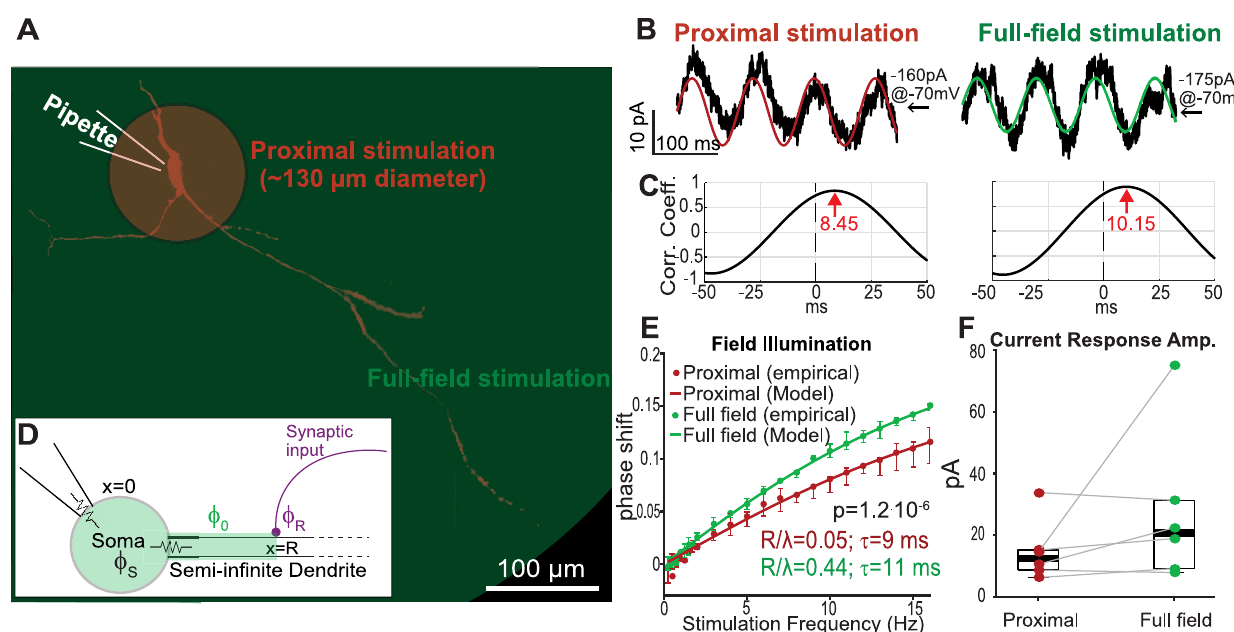
Fig 2. Somatic current responses to periodic illumination of SNr GABAergic neurons shift depending on the extent of the dendritic arbor activated. A: Collapsed two-photon image of typical SNr GABAergic neuron, filled with Alexa Flour. To compare distal and proximal inputs, optogenetic stimulation was applied under two conditions: 1) illuminating a diameter of ~130 μ m around the soma, targeting the soma and proximal dendrites (proximal, red); and 2) full-field illumination stimulating the entire dendritic arbor (full-field, green). B: Optogenetic sinusoidal waveforms at various frequencies (0.25–16 Hz) were delivered under the proximal (red) and full-field (green) stimulation conditions. Somatic whole-cell current response (black) is a phase shifted sinusoid. C: Phase shift between optogenetic periodic stimulation and somatic current response was determined by the location of the peak in the cross- correlation function between the two traces (red arrows). D: The model used to fit the data consists of a semi-infinite cable, as in Fig 2A, that is connected to an isopotential soma which adds an additional angular phase F . E: Proximal and full-field illumination conditions give rise to two distinct curves (n = 6; S p = 1.2 . 10 − 6 , ANCOVA). The response to rhythmic stimulation shows a spatial effect–the phase shift between stimulation and somatic response is larger under full-field illumination (green) compared to proximal (red). Under the assumption of a linear dendrite, we can fit the empirical results (points) with our model ( ( F F , lines). Error bars represent standard error of the mean. F: Amplitude of somatic current response was comparable between the 0 + S )/2π proximal and full-field stimulation conditions. Central marks indicate the median and box edges represent 25th and 75th percentiles.